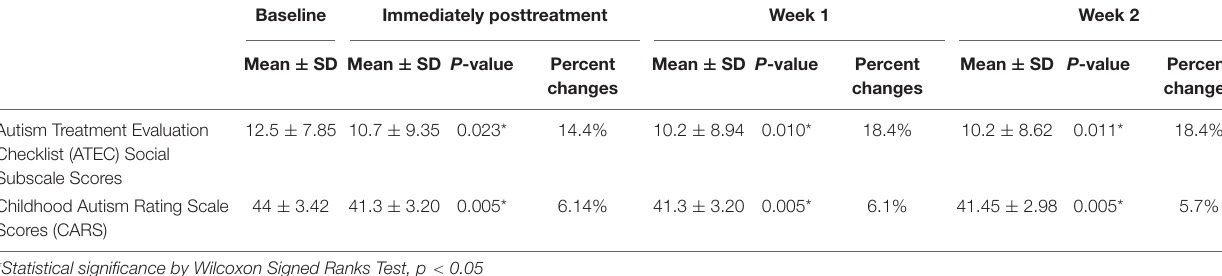
TABLE 2 | Change of ASD symptoms at immediately posttreatment, week 1, and week 2 after treatment ( n = 10).